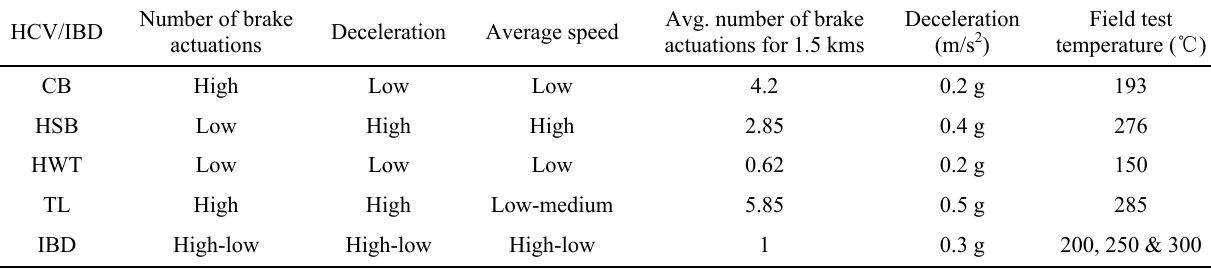
Table 4 Inputs to OEM based on field